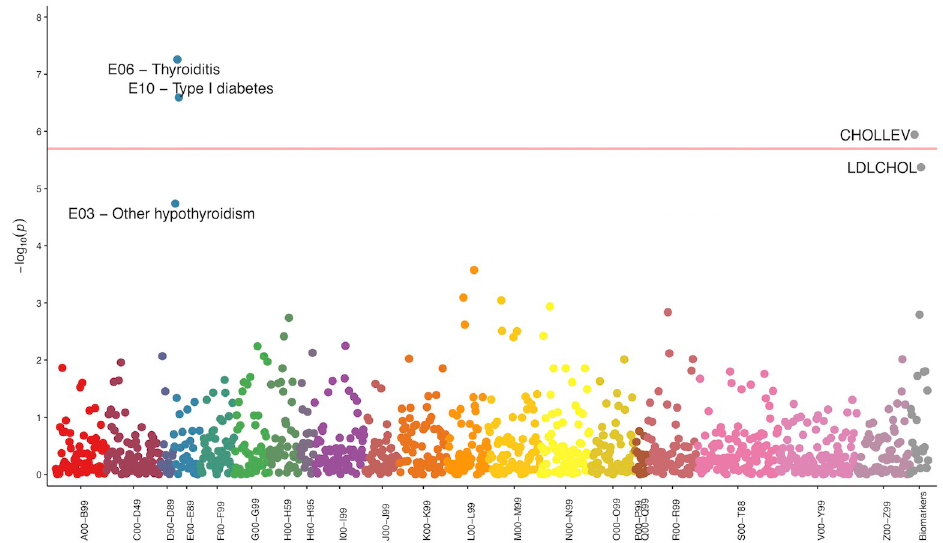
Fig 2. PheWAS Plot for rs9273349. Pink line corresponds to the significance threshold. Groups were defined by the ICD-10.